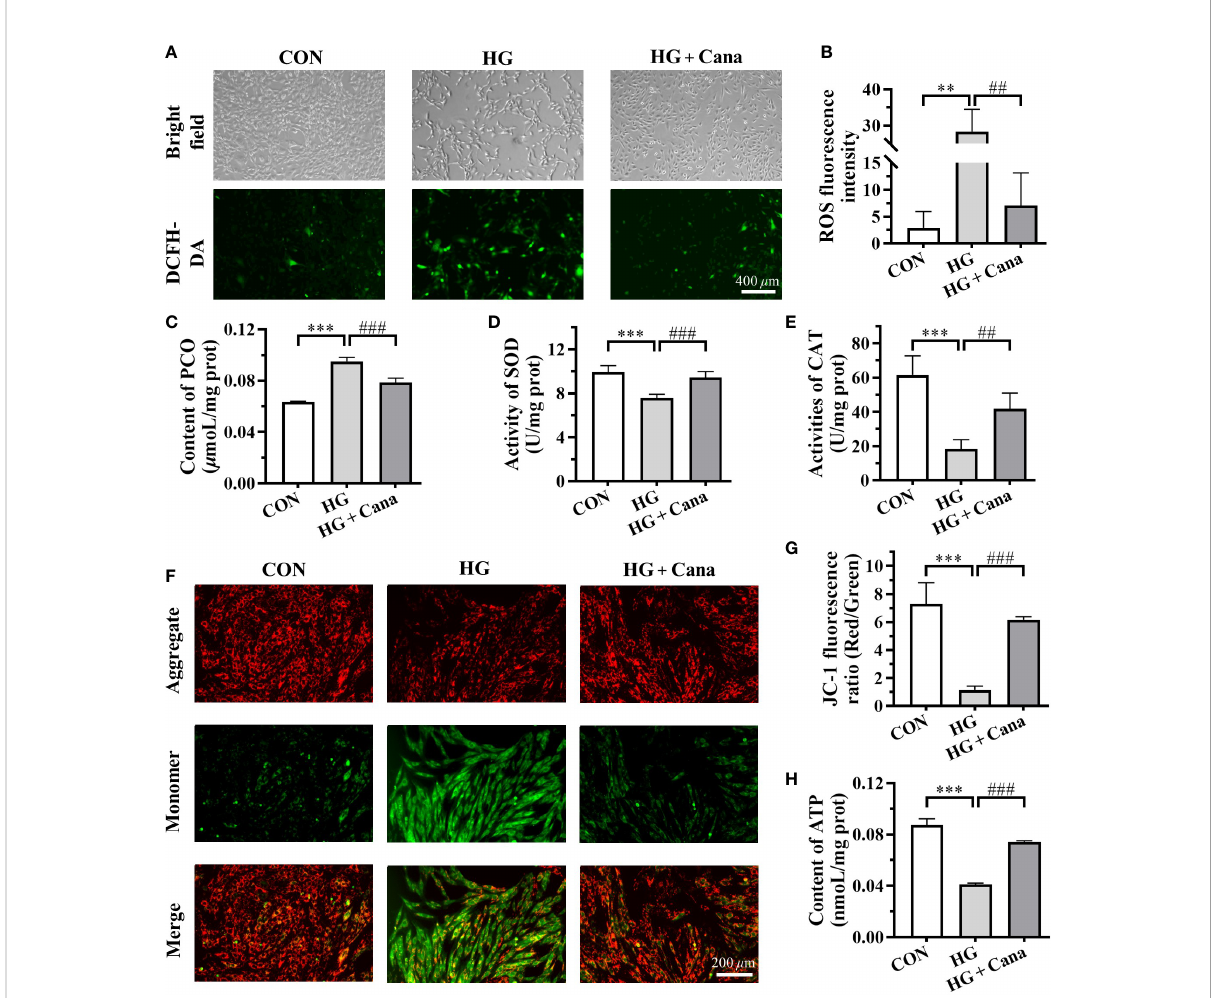
FIGURE 4 Canagli fl ozin improves oxidative stress and mitochondrial damage induced by high glucose. (A) The images and (B) fl uorescence intensity of intracellular ROS stained by DCFH-DA (Scale bar: 400 µ m). (C) Content of PCO; Activities of (D) SOD and (E) CAT in H9C2 cells of each group. (F) The images and (G) JC-1 fl uorescence ratio of MMP analyzed by JC-1 kit (Scale bar: 200 µ m). (H) Content of ATP. ROS, reactive oxygen species; PCO, protein carbonyl; SOD, superoxide dismutase; CAT, catalase; MMP, mitochondrial membrane potential; ATP, adenosine triphosphate. (**: P<0.01; ***: P<0.001; compared with CON group; ##: P<0.01; ###: P<0.001; compared with HG